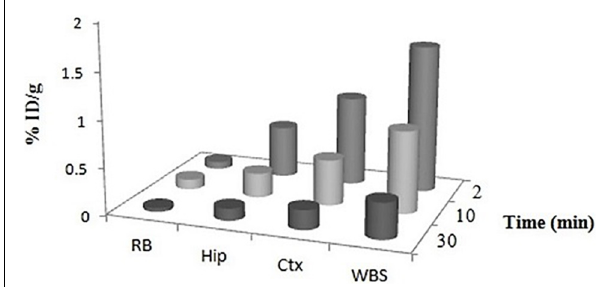
FIGURE 8 | Regional uptake of 99m Tc–DT(Ch) 2 in mice brain. WBS, whole brain section; Ctx, cortex; Hip, hippocampus; RB, rest of brain at 2, 10, and 30 min